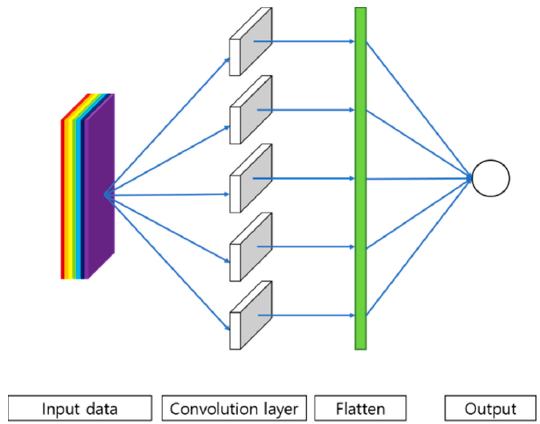
Figure 22. Training process of the algorithm.